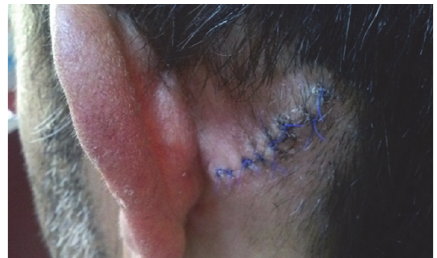
Figure 1: Postauricular sinus excision location.